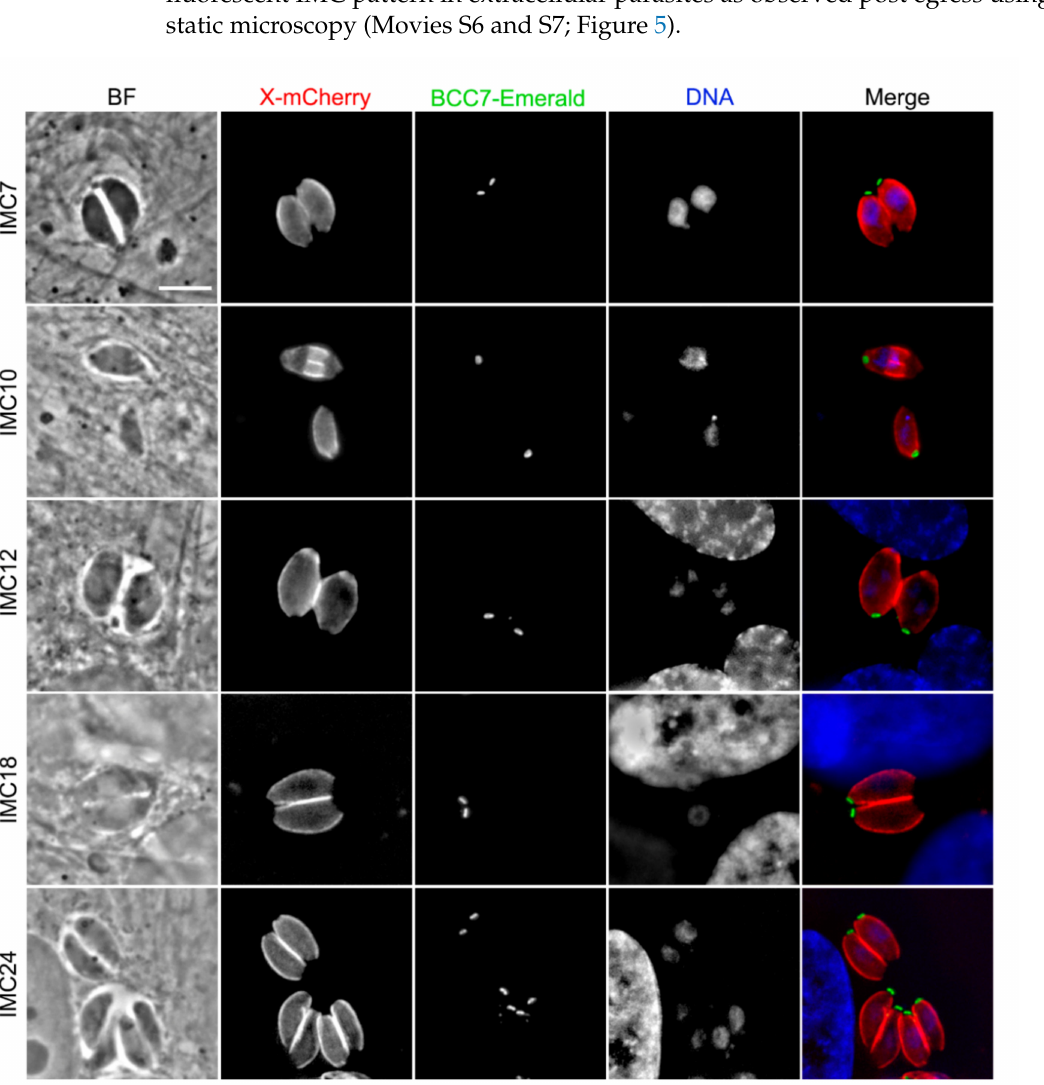
Figure 4. Images of IMC proteins identified in this study as putative BCC7-binding proteins. HFF monolayers were infected with freshly egressed parasites expressing endogenously fused BCC7-mEm (green) and IMC-mC tagged proteins (red). Samples were fixed and stained with DAPI (blue) before image acquisition (ZEISS ApoTome.2 microscope). The elongating IMC from the budding progeny contains IMC10. Scale bar, 5 µ